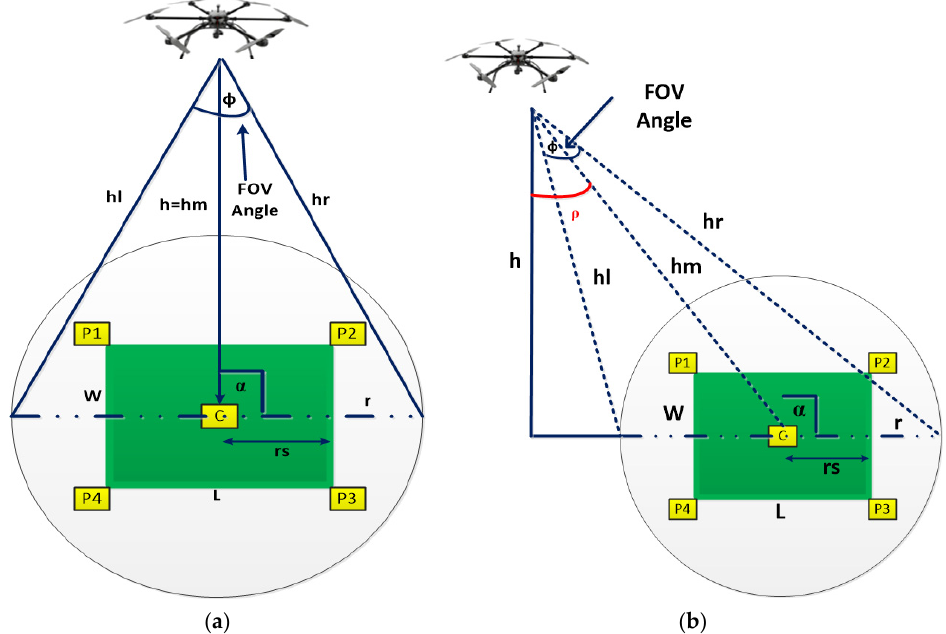
Figure 5. Sub area sample ground image collection using UAV ( a ) when UAV is vertical about point C and camera is vertically down ( b ) when UAV and camera are at an angle ρ from point C . As given in Figure 5a,b, L and W represent the length and width of each sample, rs shows half of the length , r represents the radius of the imaginary circle viewed by the drone camera , h is the vertical height of the drone with respect to ground , hr, hm and hl show the sides of the triangles as perceived in the figures. The field of view (FOV) angle of the drone camera is represented as φ , the angular distance of the drone body from the centroid of the samples is measured by ρ , and α represents the angle between the ground axis and hm . As shown in the figure, the quadrilateral polygon has four corner points, P1, P2, P3, P4, and a center, C . From the geometric interpretation of Figure 5a, the height of the drone can be cal- culated using the following expression, with α = 90 degrees.